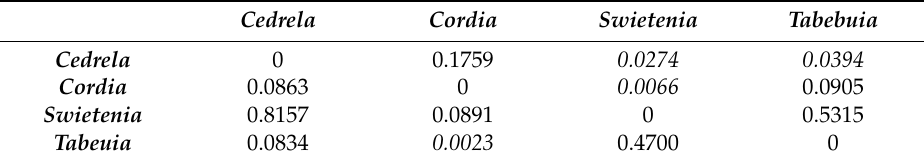
Table 4. p -values obtained from PERMANOVA analysis when comparing both parasitoid Hymenoptera families assemblages (above the diagonal) and Coleoptera families assemblages (below the diagonal) associated to every native tree species in the study. In italics when significant ( p < 0.05).